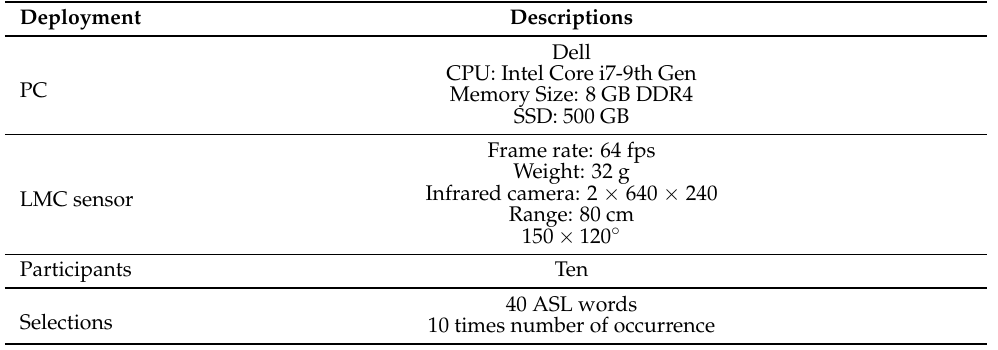
Table 5. Execution